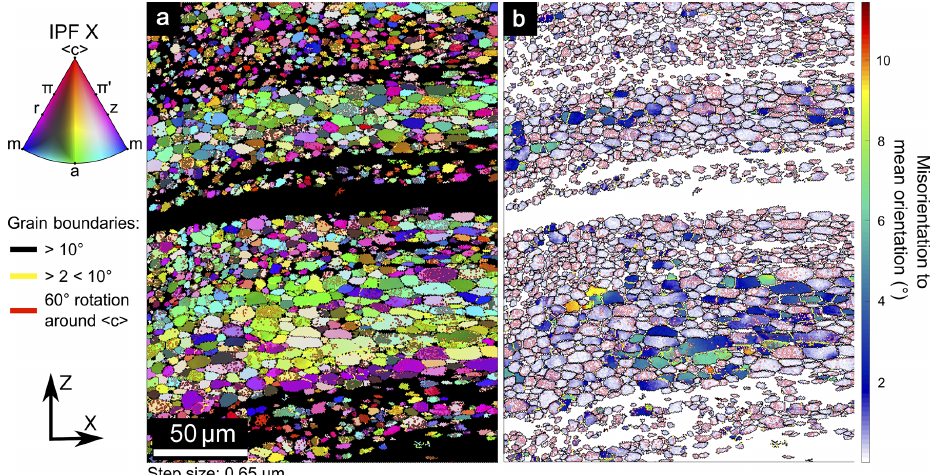
Figure 8. EBSD maps for the region of interest in Fig. 1b. Panel (a) shows an inverse pole figure map coloured for the X direction of finite strain. Colours in panel (b) relate each pixel’s orientation to the mean orientation of the grain that hosts the pixel.